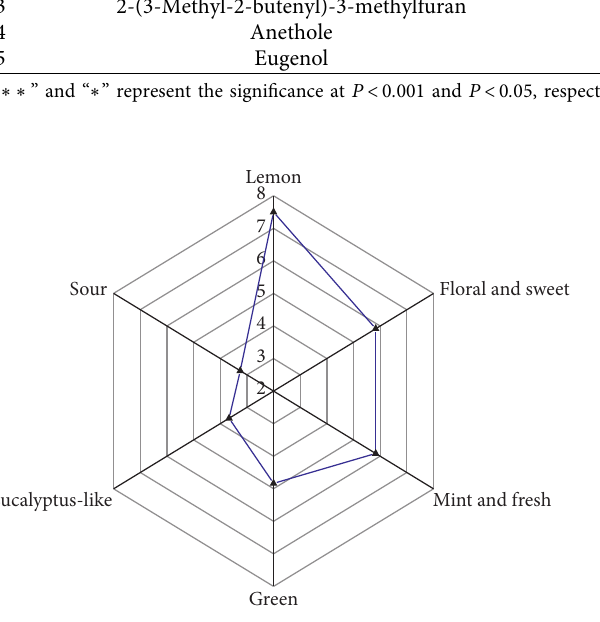
Figure 2: Aroma profiles of Litsea pungens Hemsl. fruit by quantitative descriptive analysis.